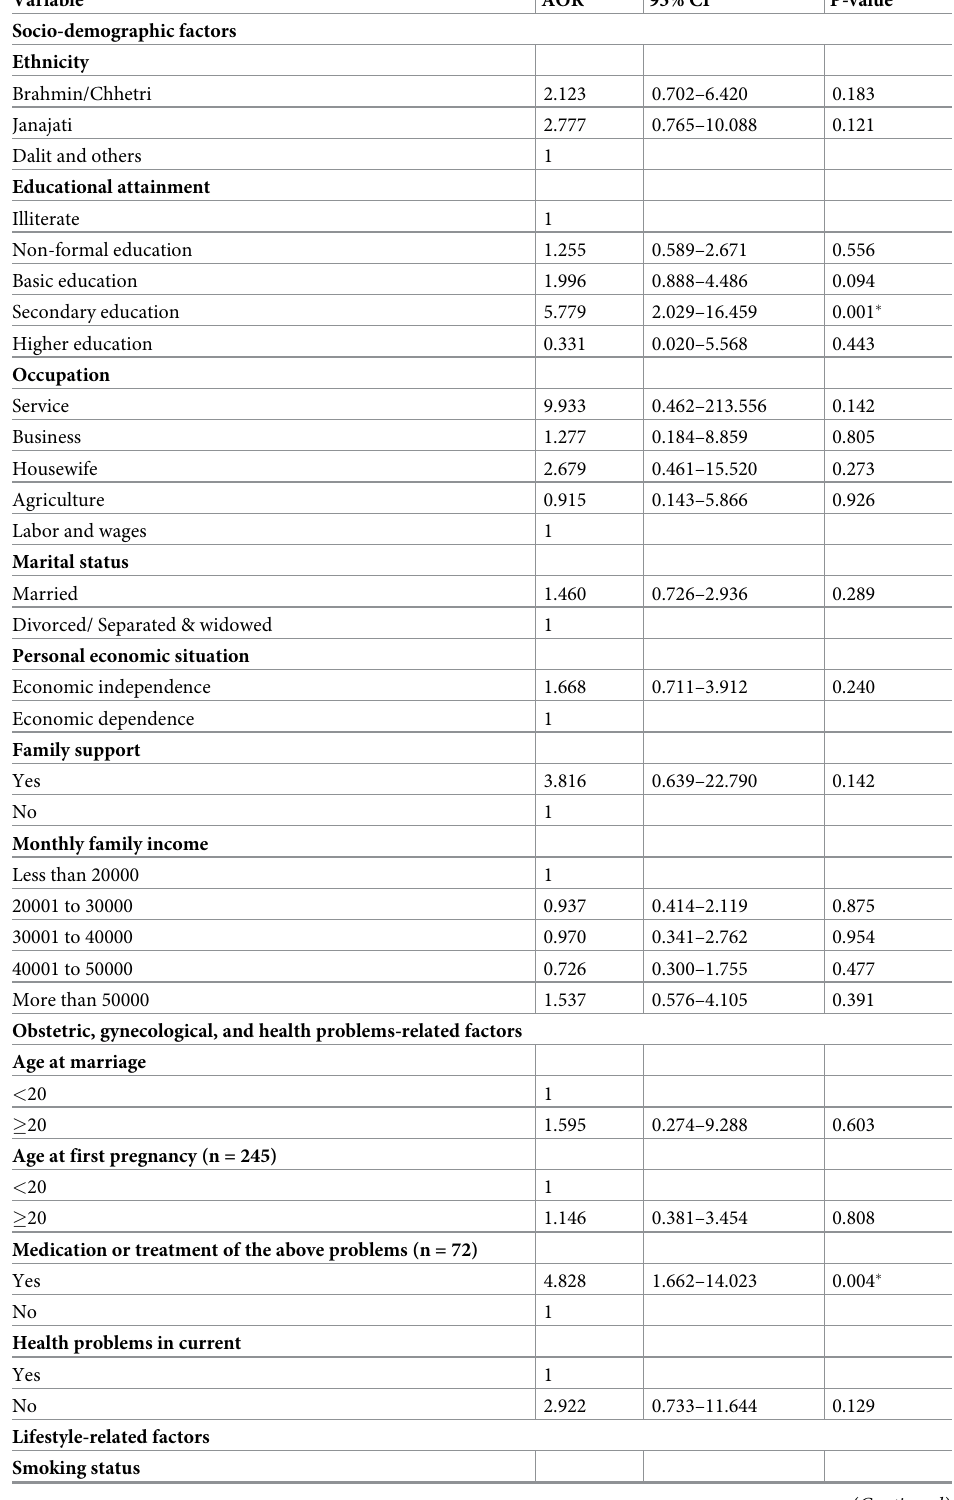
Table 6. Multivariate analysis of predictors of quality of life among menopausal